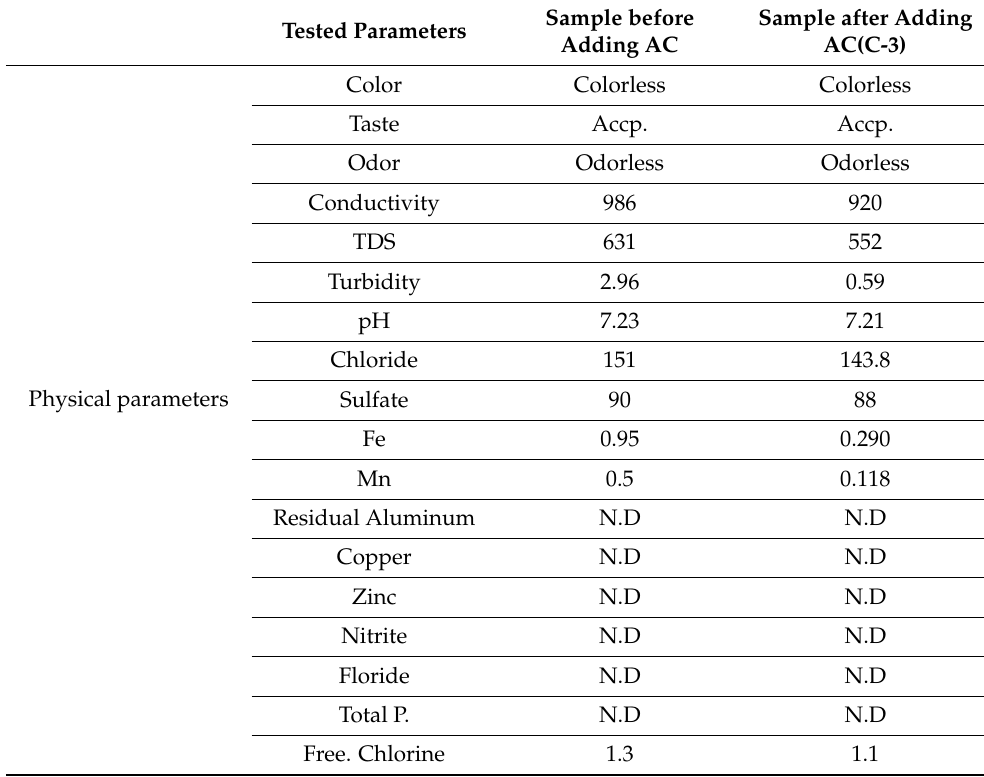
Table 13. Treatment of Fe(III) and Mn(II) in ground water by using AC(C-3) adsorbent. Tested Parameters